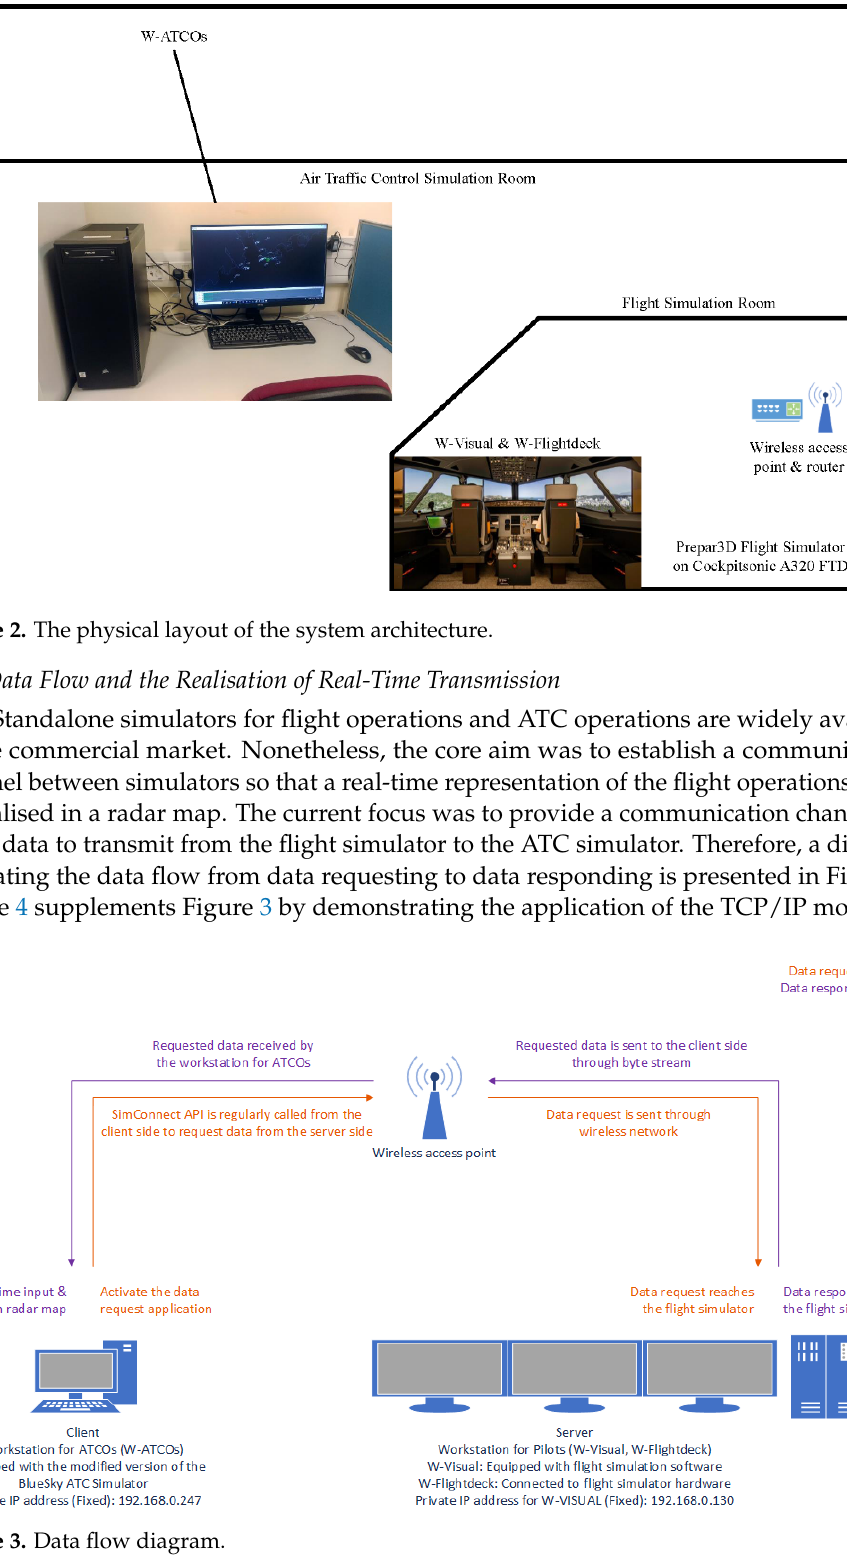
Figure 3. Data flow diagram.